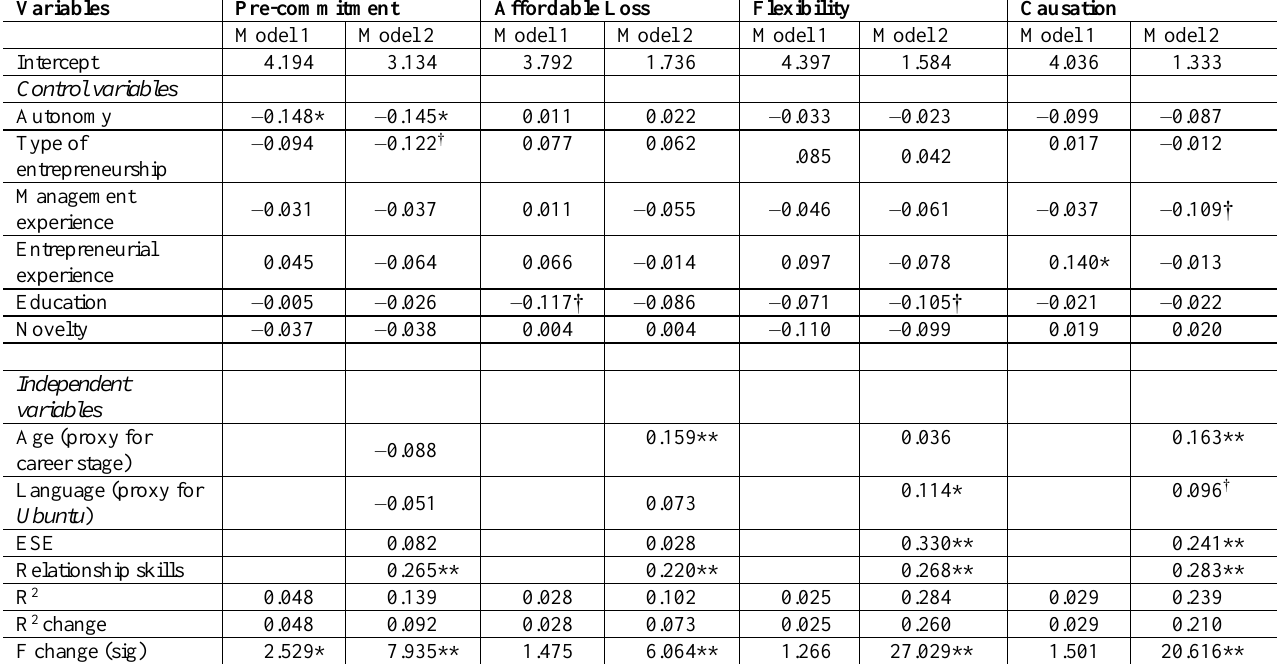
Table 4: Hierarchical regression analysis on variables for cognitive ambidextrous